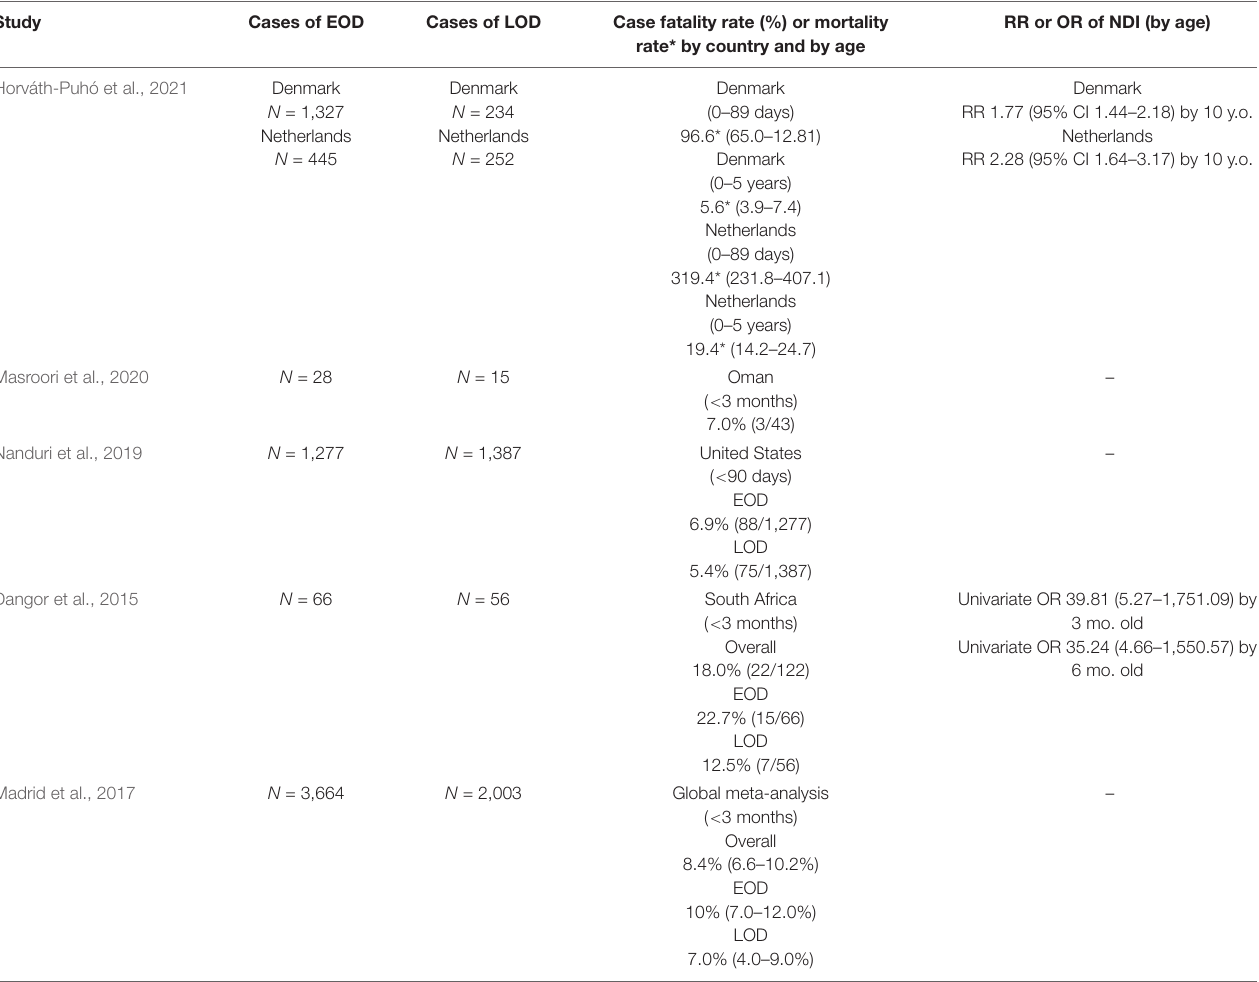
TABLE 2 | Studies reporting rates of case fatality, mortality, and NDI for GBS EOD and LOD. Study Cases of EOD Cases of LOD Case fatality rate (%) or mortality